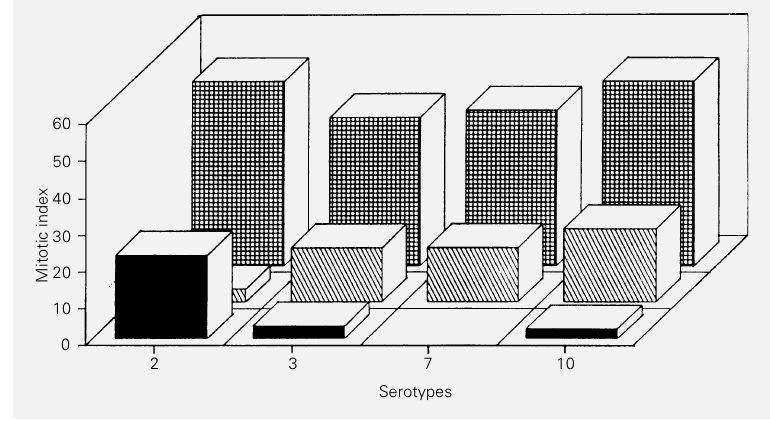
Figure 2 - Effect of supernatants of Ureaplasma urealyticum serotypes on the mitotic index of human lymphocytes in vitro . S 1 ( ) = Supernatants of serotypes 2, 3, 7 and 10 at the